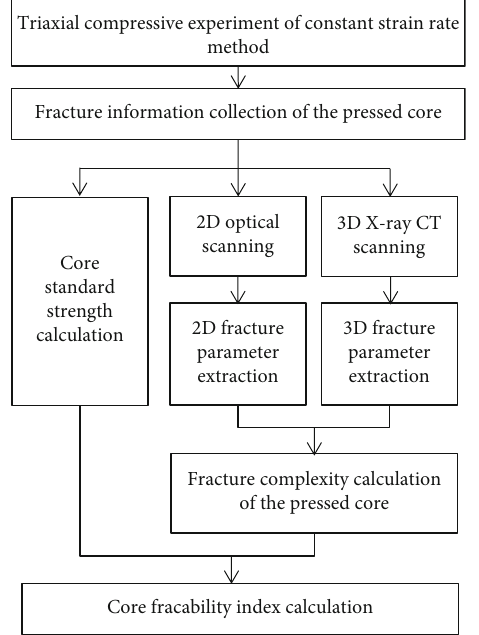
Figure 1: Technical fl ow of the shale fracability experiment analysis method based on quantitative FRAC of the fractured core.